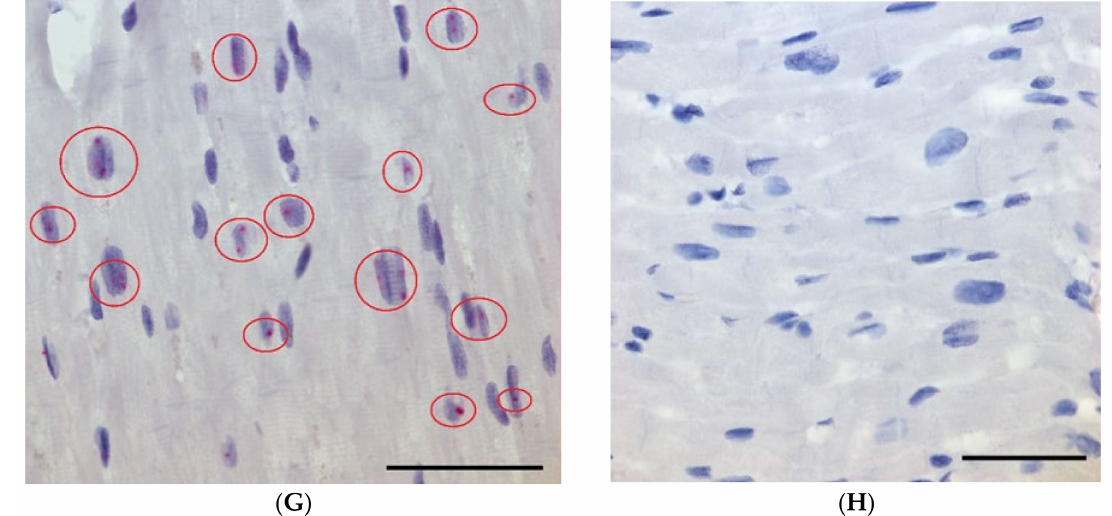
Figure 5. RNA Scope showing VASH1-AS1, PCAT19 and the novel VTCN1-AS expression in cardiomyocytes. The dark blue haematoxylin staining indicates the cell nucleus. Red circles indicate the location of the red RNA-Scope probes. ( A ) VASH1-AS1 probe nuclear localization at 63 × magnification, ( B ) VASH1-AS1 probes cytoplasmic localization at 63 × magnification ( C ) and ( D ) Shows PCAT19 probe nuclear and cytoplasmic localization at 63 × magnification ( E ) and ( F ) Shows novel (VTCN1-AS) probe nuclear and cytoplasmic localization at 63 × magnification ( G ) NEAT1 lncRNA positive control with an exclusively nuclear location ( H ) Negative control Scale bar = 50 µ